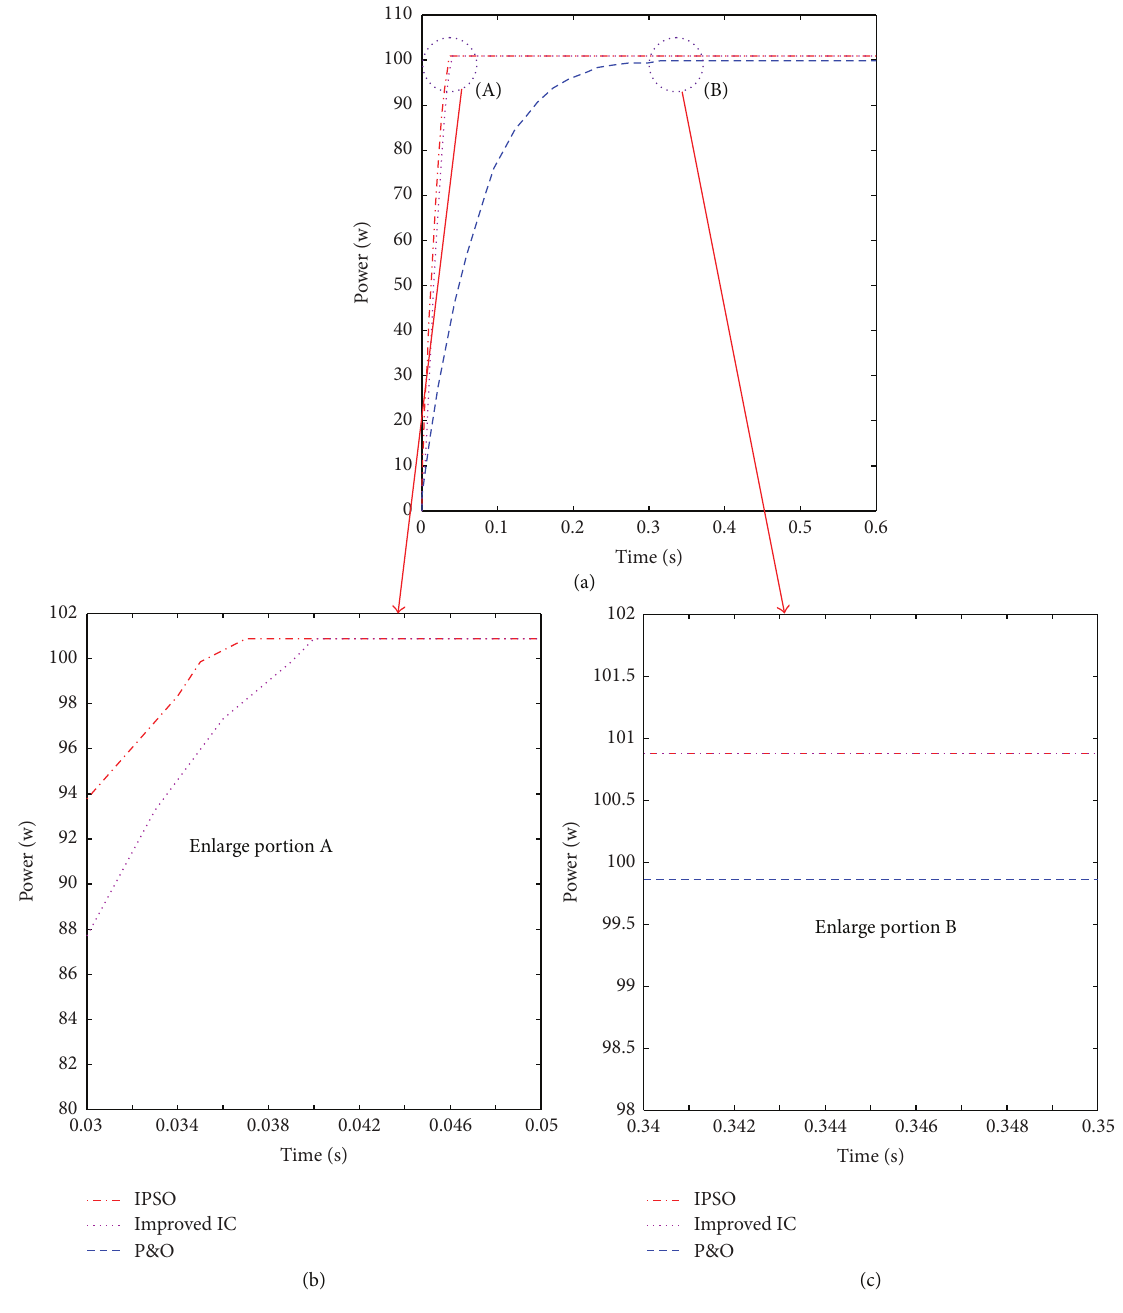
Figure 8: (a) depicts the performance comparison between IPSO, modified IC, and P&O. (b) Enlarge portion A. (c) Enlarge portion B.